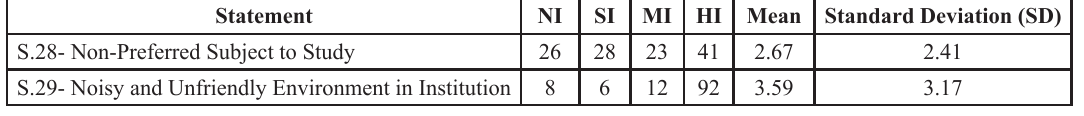
Table 3: Influential Statements and their outcomes (S.28 to